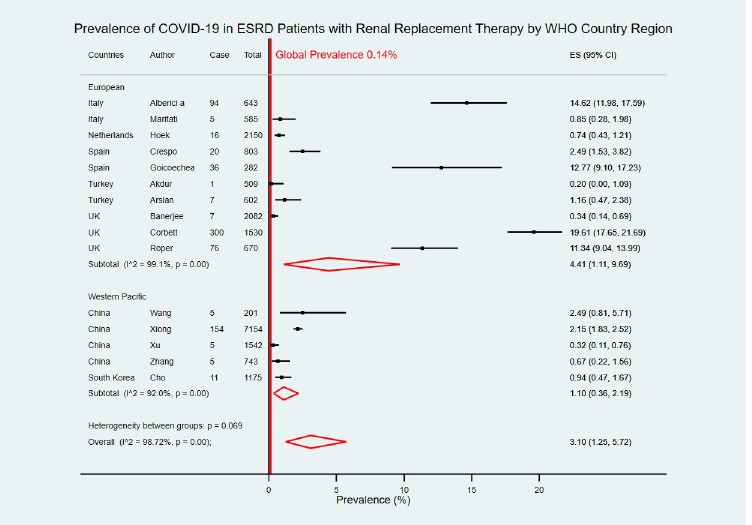
Fig 4. Forest plot of the prevalence of COVID-19 in ESRD patients with RRT by WHO country region. The figure summarizes the number of COVID-19 confirmed cases in ESRD patients with RRT and the total number of ESRD patients with RRT in 15 eligible studies with subgroup analysis by WHO country regions. The forest plot represents the estimated prevalence of COVID-19 in ESRD patients with RRT for each study (black boxes), with 95% confidence intervals (95% CI; horizontal black lines). The estimated pooled prevalence for each subgroup was presented with a red diamond. The overall estimated pooled prevalence (last red diamond) was 3.10% (95% CI 1.25–5.72). The global average prevalence (vertical red line) was 0.14%. The meta-analysis used a random-effects model with the exact method for confidence interval estimation. ES, effect size. I 2 , test for heterogeneity.